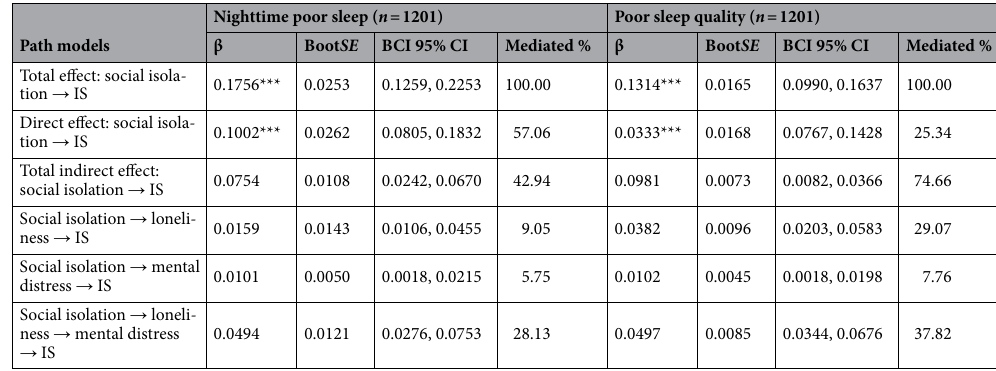
Table 5. Indirect effects of social isolation on specific sleep problems through loneliness and mental distress as mediators. Models were adjusted for age, sex, residential status, marital status, level of education, employment status, physical activity, and multimorbidity. Empirical 95% confidence interval does not overlap with zero. β Unstandardized regression coefficients are reported, BootSE bootstrapping standard error, IS impaired